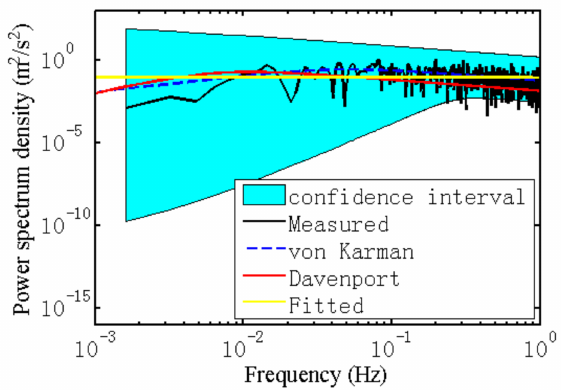
Figure 33. Power spectra of the longitudinal wind component at 10 m.